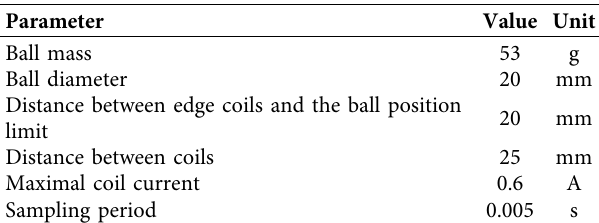
Figure 1: A schematic drawing of the magnetic manipulator system. Table 1: Magnetic manipulator